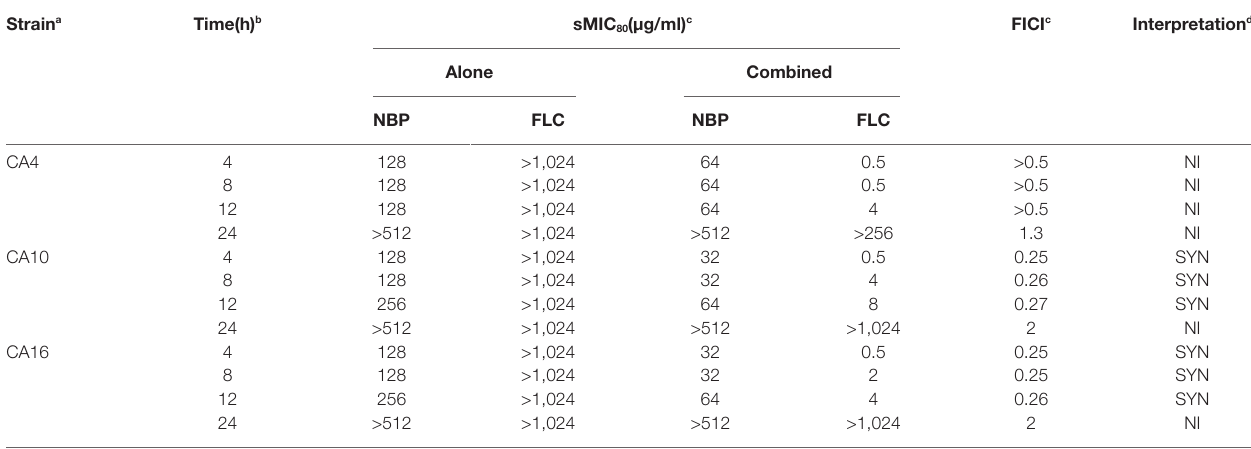
TABLE 3 | Drugs interactions of NBP and FLC against preformed C. albicans biofilms in vitro . Strain a Time(h)